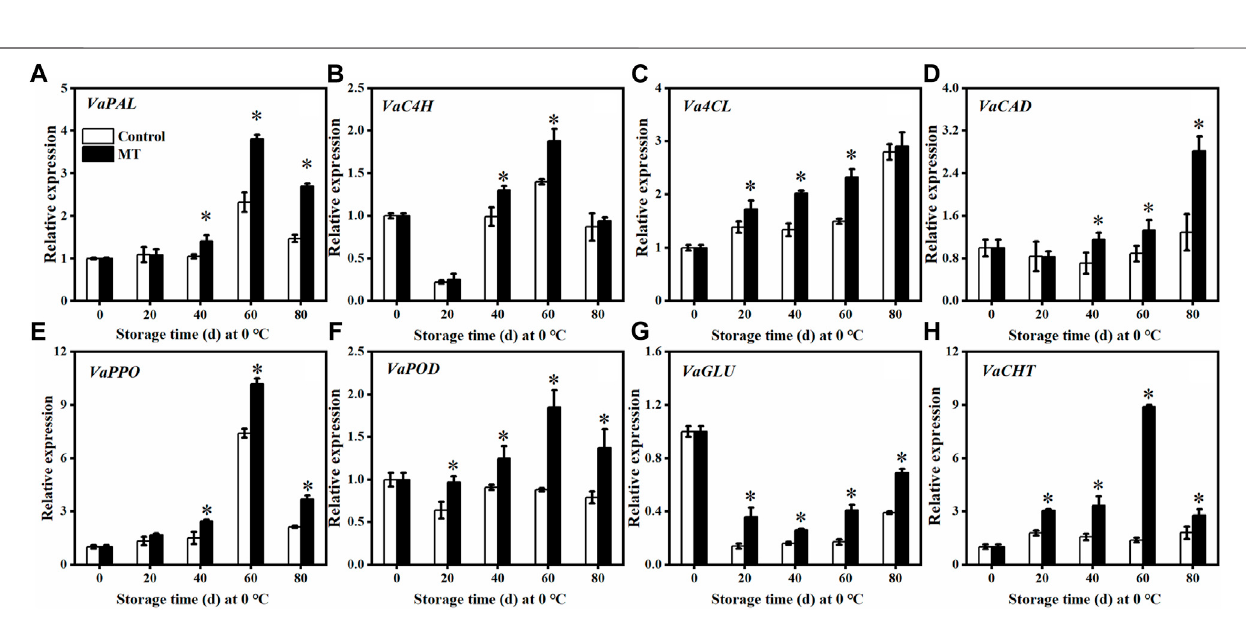
Frontiers in Chemistry |